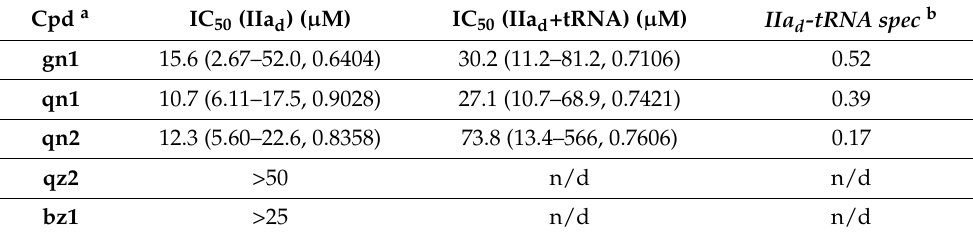
Table 1. 50% inhibitory concentrations of the pharmacophore hits for IRES subdomain IIa conforma- tional modulation measured by FRET experiments.